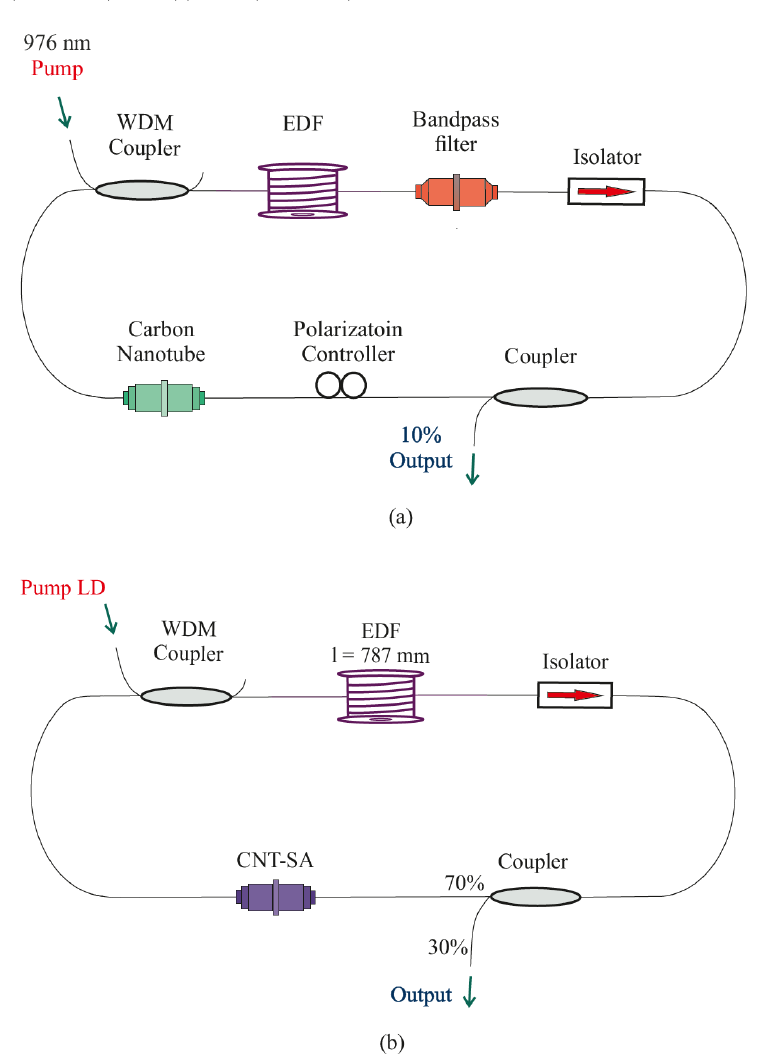
Figure 17. Schemes of fiber lasers using SWCNTs: ( a ) a ring fiber laser with 29.1 femtosecond jitter and ( b ) fiber laser ring circuit with 490 attosecond jitter.